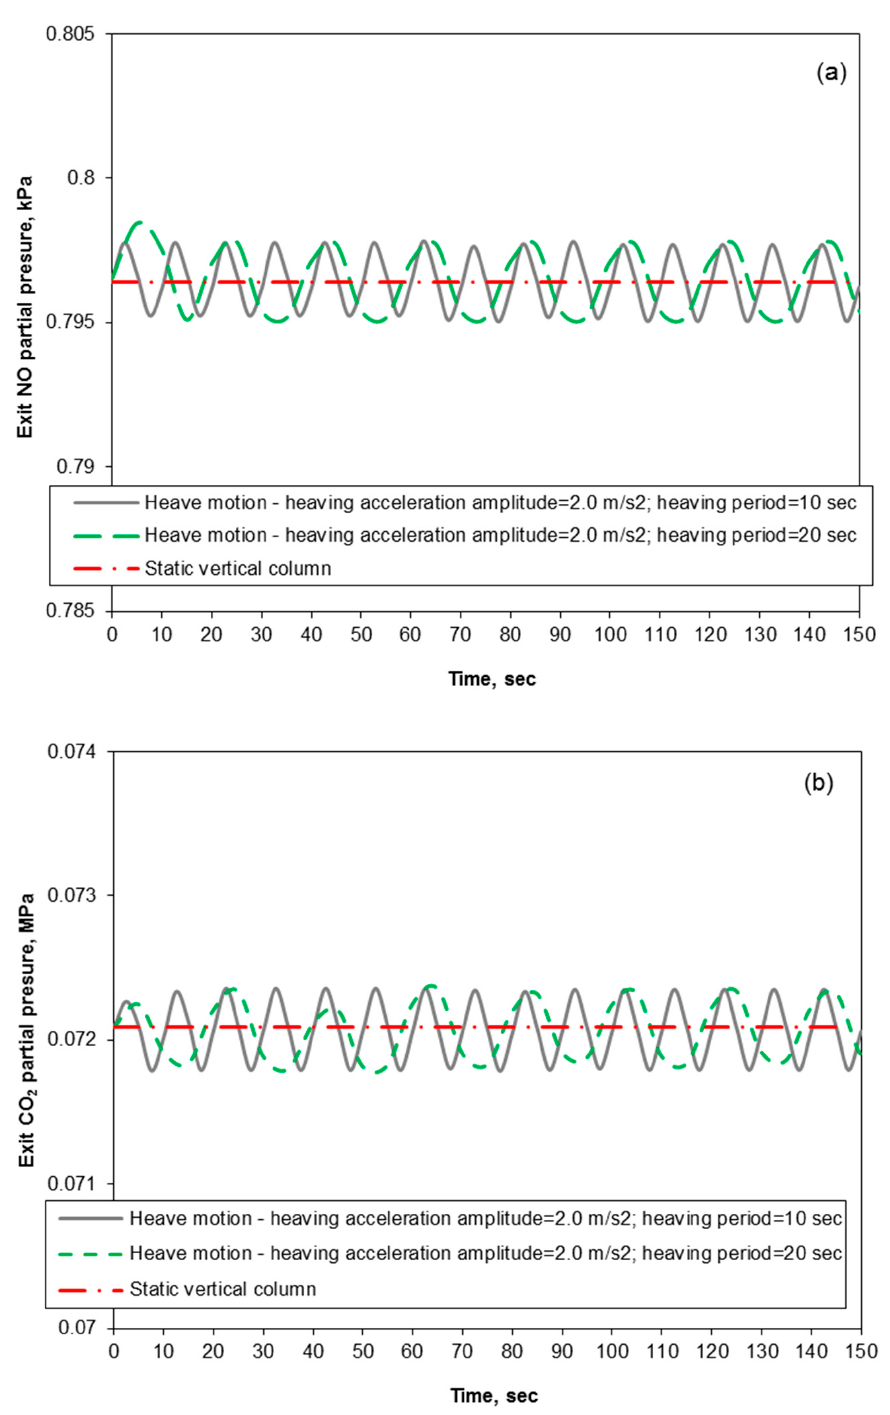
Figure 20. Time-dependent exit NO ( a ) and CO 2 ( b ) partial pressure in a seawater scrubber under heaving motion conditions at different heaving motion periods (Packed-bed column with Raschig super-Rings; H = 5 m; Pressure = 1.5 MPa).